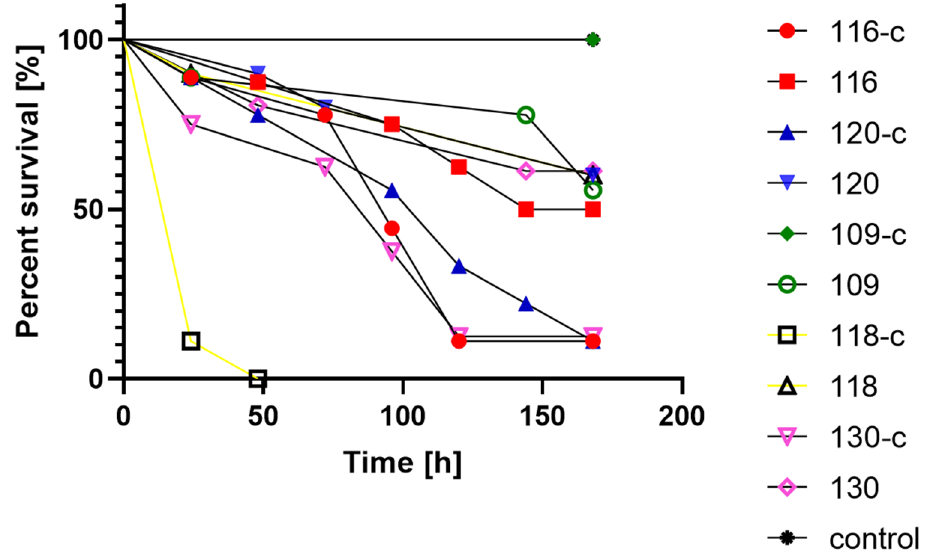
Figure 4. Survival curves of G. mollonella larvae injected with L. monocytogenes ; c—ceviche.